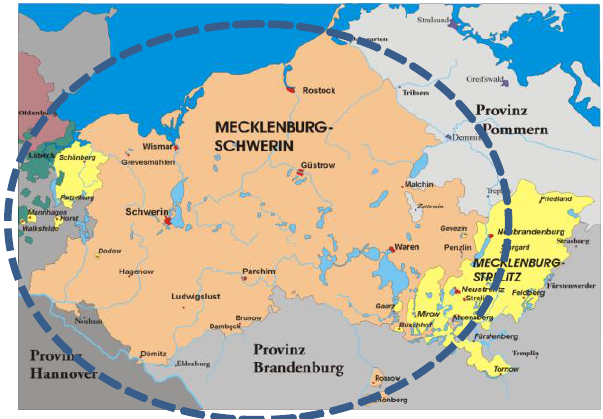
Figure 1. Area coverage of Mecklenburg from 1786 in the today’s boundaries of Mecklenburg-Western